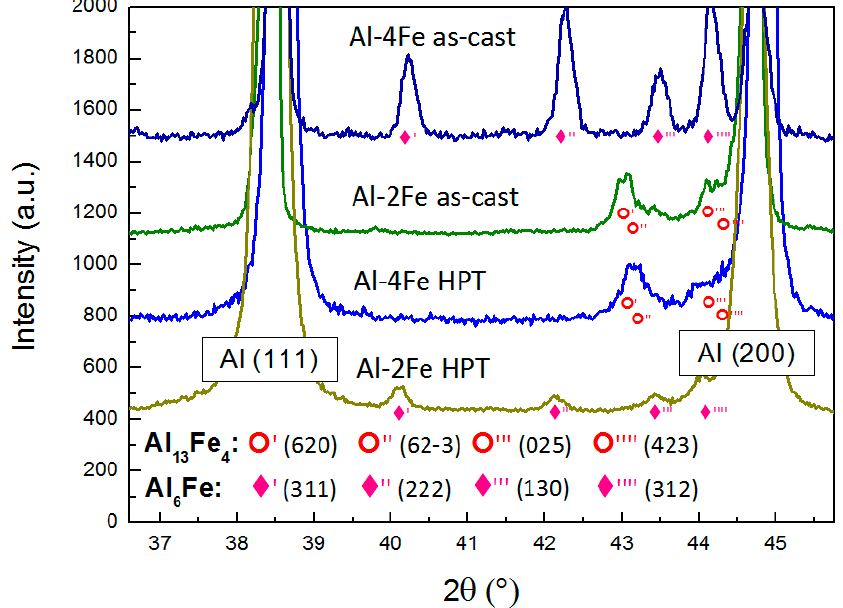
Figure 2. XRD profiles of the Al-2Fe and Al-4Fe alloys in the as-cast state and after HPT. After HPT the opposite trend is observed: Al 6 Fe and Al 13 Fe 4 phases are formed in the Al-2Fe and Al-4Fe alloys, respectively, while the peaks of precursor particles disappear.